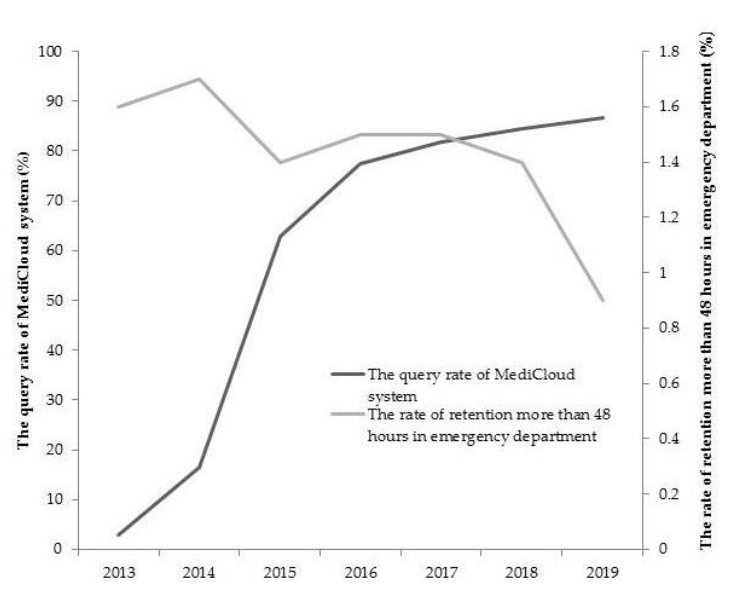
Figure 2. The time series of the annul query rate of MediCloud system and the retention rate of more than 48 h in emergency department. Table 1. The percentage of each healthcare quality during 2013–2019 by Poisson regression. Quality